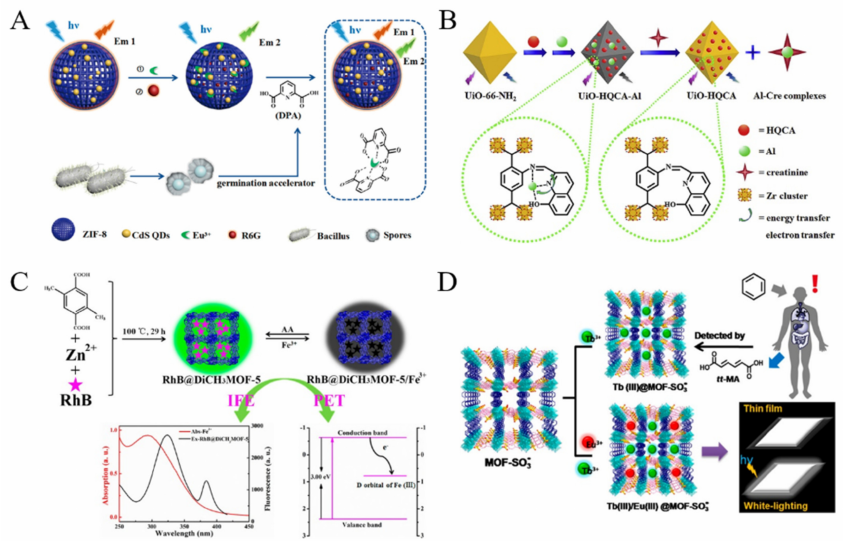
Figure 9. ( A ) Schematic illustration of the preparation of R6G/Eu-CdS@ZIF-8 and its application for DPA detection. Reproduced with permission [147]. Copyright 2020, American Chemical Society. ( B ) Schematic illustration of the HQCA and Al 3+ -modified MOFs-based fluorescent sensor for